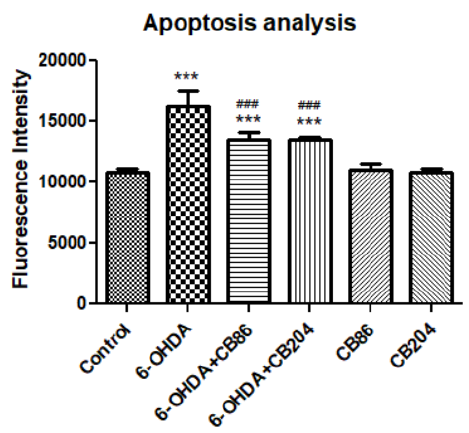
Figure 6. Apoptosis assay: Apoptosis was induced by the exposure of PC12 cells to 80 µM 6-OHDA for 24 h. The PC12 cells were treated simultaneously with CB86 or CB204 (25 µM each) for 24 h. Results are expressed by mean ± SD ( n = 8 replicates in each group). ANOVA followed by Bonferroni’s post-hoc test was performed, F (5, 42) = 85.07, p < 0.001. *** compared to control and ### compared to 6-OHDA, p < 0.001 for all comparisons.